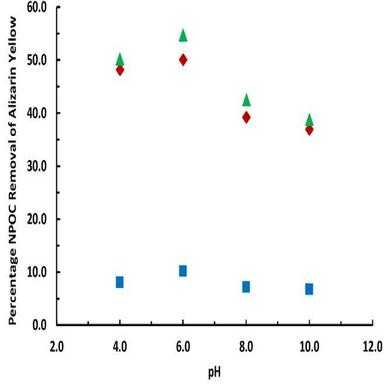
Perecntange removal of NPOC of Alizarin Yellow at different pH values for photolytic and photocatalytic processes (: 1.0 mg/L).